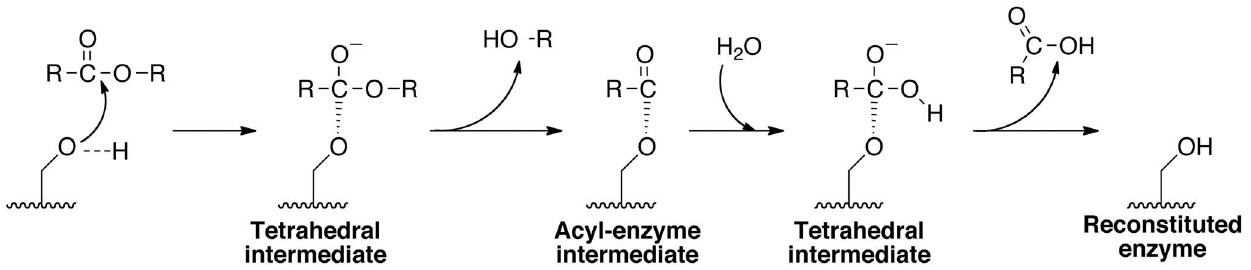
Figure 2. Proposed catalytic mechanism for the active site of Pat17. Asp215 (not shown) acts as a general base and activates the Ser77 nucleophile by abstracting its terminal hydrogen. The activated Ser77 (shown as –OH) attacks the acyl carbon of the substrate forming a tetrahedral intermediate whose negative charge is shielded by the oxyanion hole of Pat17 (not shown). Loss of R-OH yields an acyl-enzyme intermediate that is hydrolyzed rapidly (passing through another tetrahedral intermediate) to release the acyl moiety and regenerate the